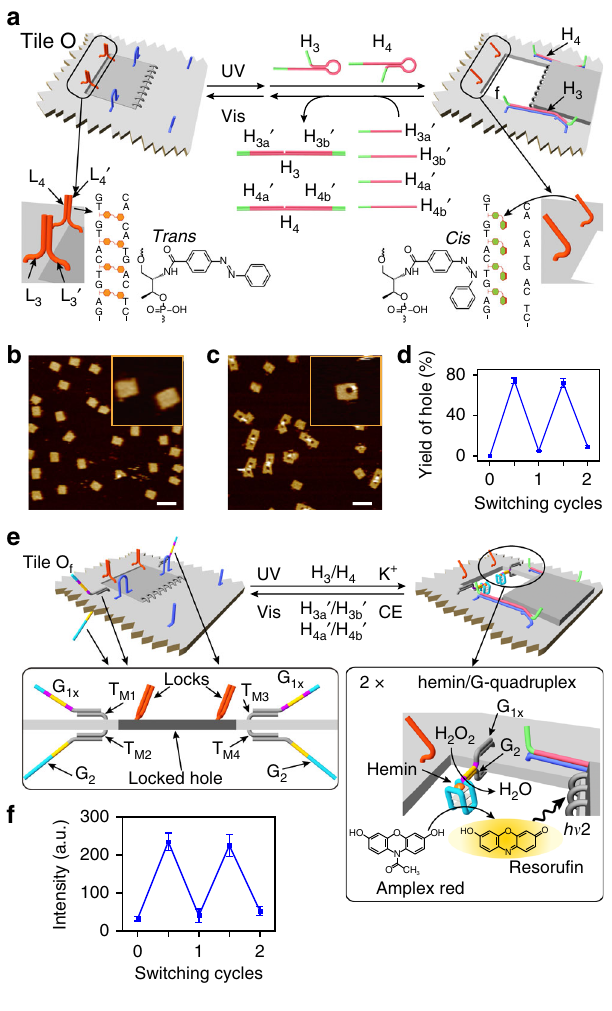
in the presence of the helper and counter-helper strands, the nanoholes are cycled between open and closed states, respectively. Figure 4b, c show the AFM images of the intact closed tiles and the photogenerated nanohole-containing tiles ( λ = 365 nm) in the presence of the helper hairpins, respectively. Figure 4d shows the cyclic opening and closure of the nanoholes upon the photo- isomerization of the azobenzene units in the presence of the helper and counter-helper strands. The yield of nanohole- containing tiles is ca. 74% (Supplementary Figs 20 – 24 and Sup- plementary Tables 10 – 14). As before, the photoisomerization of the azobenzene units ( λ = 365 nm) and the added hairpins H 3 /H 4 are essential to generate the high yield of the stretched open “ window ” (see Supplementary Figs. 25 – 27 and Supplementary Tables 15 and 16, and accompanying discussion).